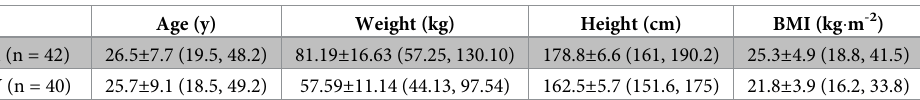
Table 1. Subject characteristics, listed as mean ± SD as well as lower and upper bounds for men (M) and women